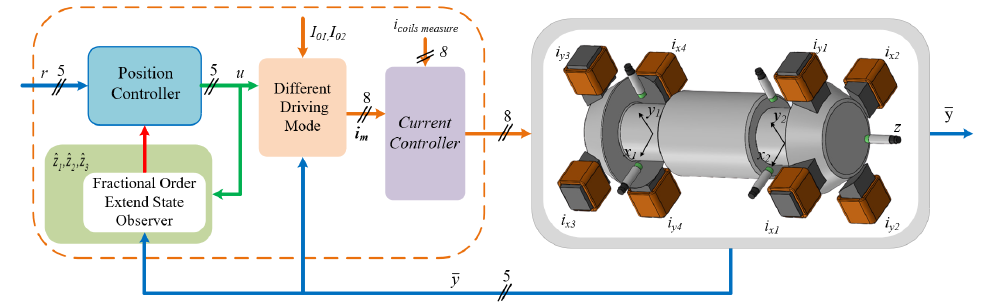
Figure 6. Control strategy.